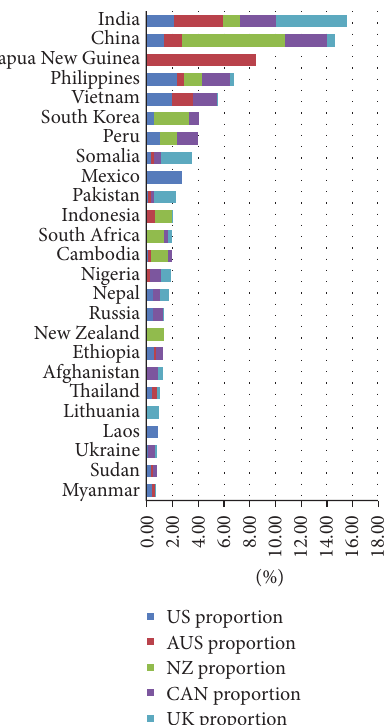
Figure 2: Combined averages of foreign-born TB cases, 2005–2009.